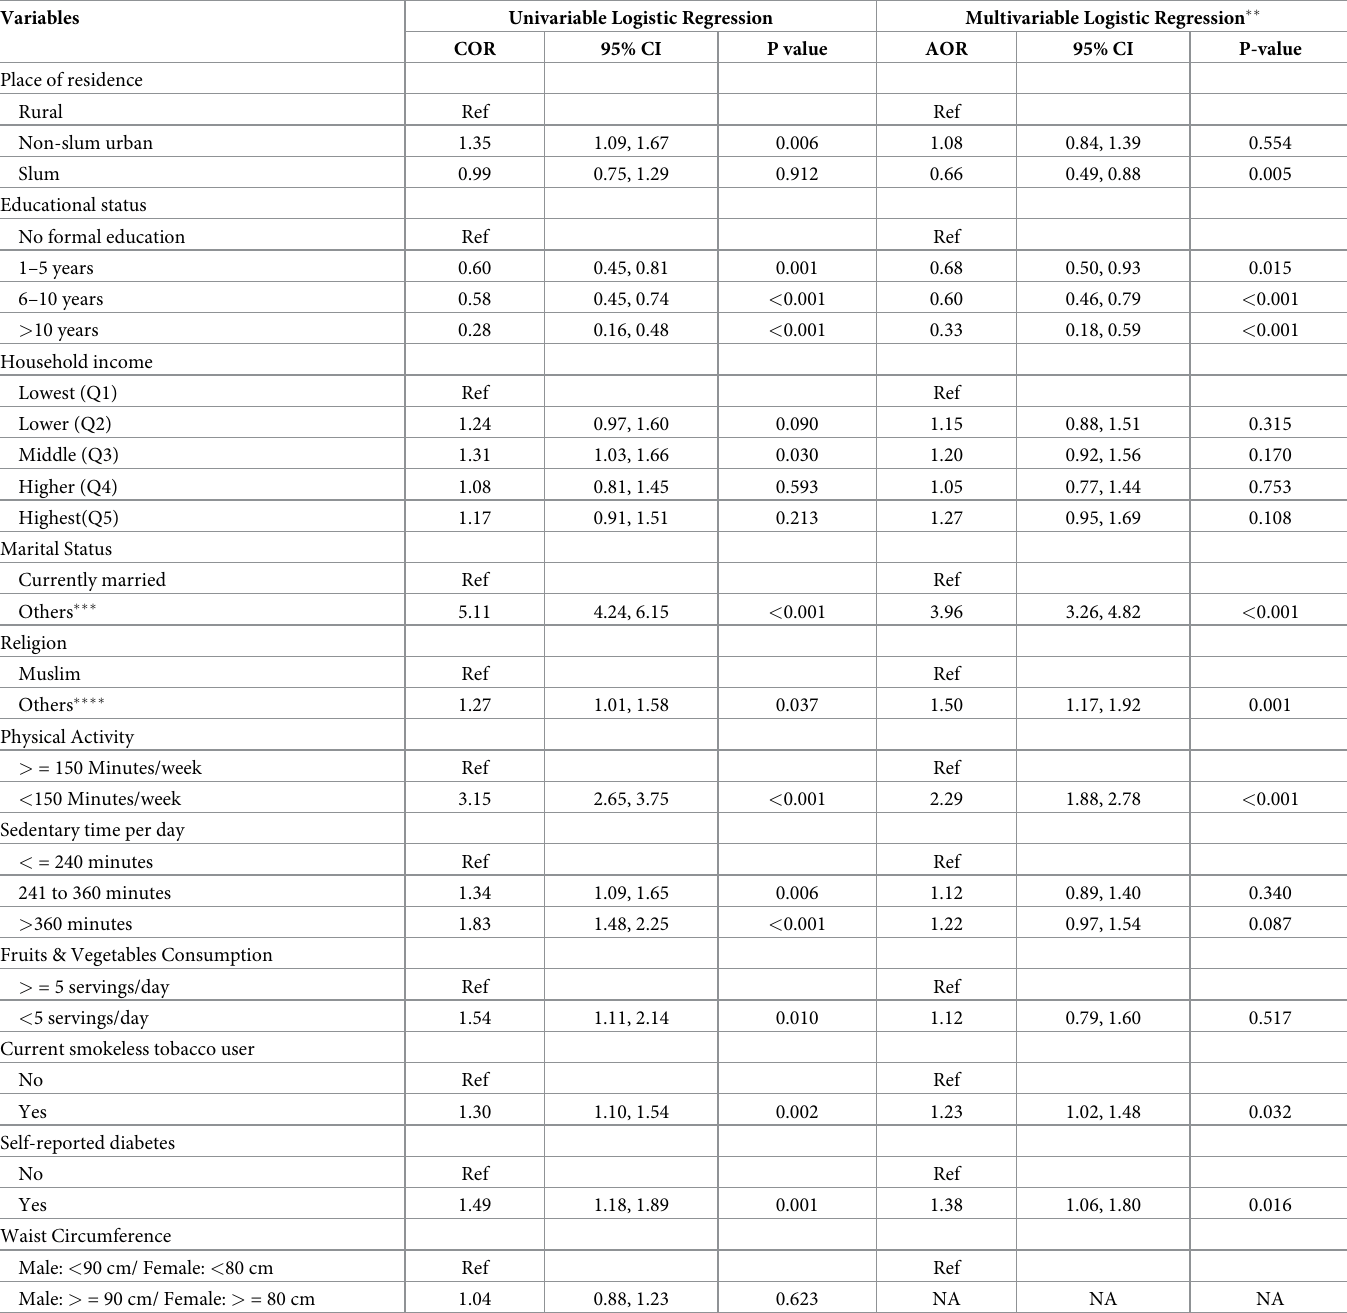
Table 4. Univariable and multivariable logistic regression results with potential determinants of elevated CVD risk � 10% (for females) �